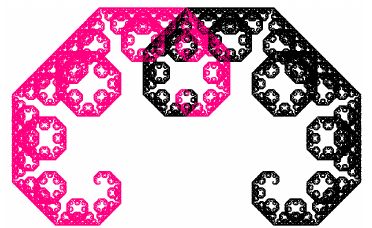
Figure 8. The Lévy